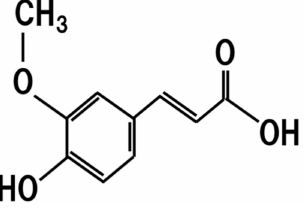
Figure 6. Chemical structure of ferulic acid.